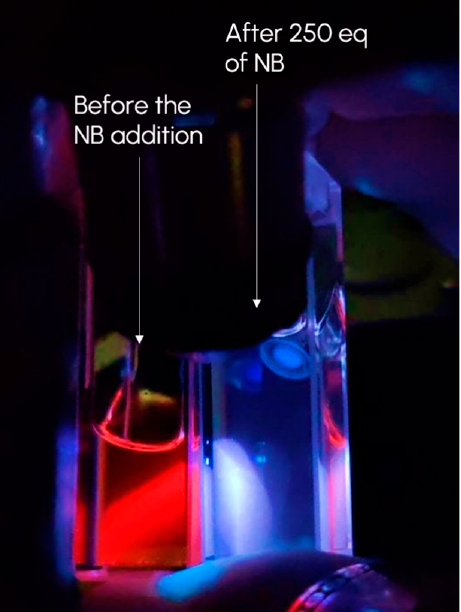
Figure 7. The photo demonstrating visible changes of ZnPIP (7.3 × 10 − 7 M) solution emission colour (under the UV light of 350 nm) before and after addition of 250 eq of